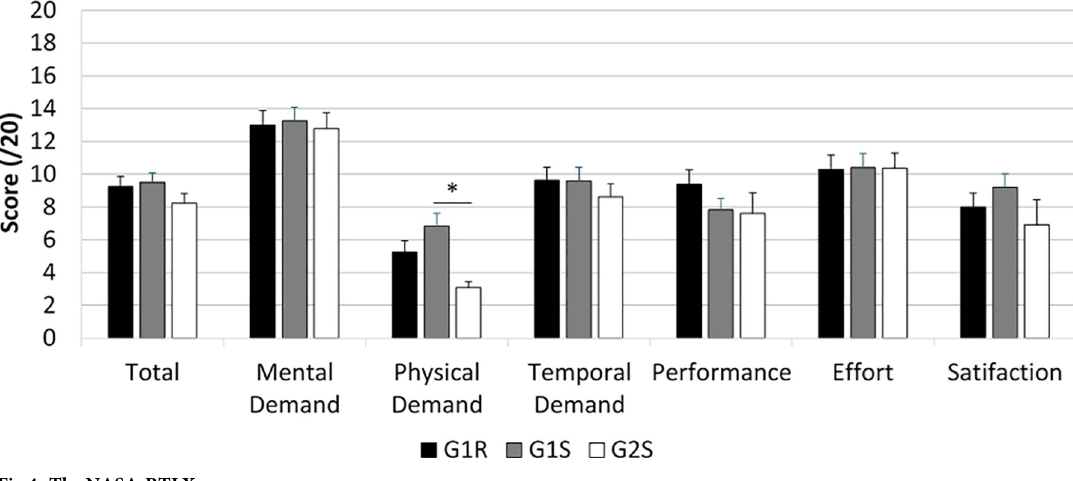
Fig 4. The NASA-RTLX